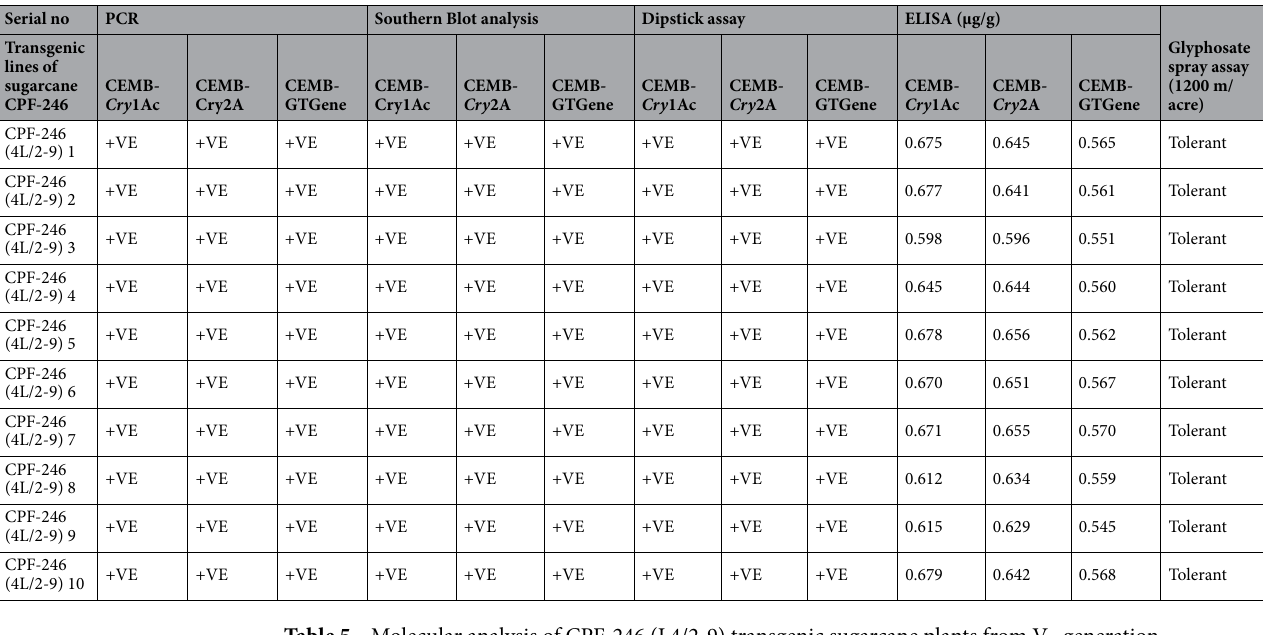
Table 5. Molecular analysis of CPF-246 (L4/2-9) transgenic sugarcane plants from V 2 -generation.